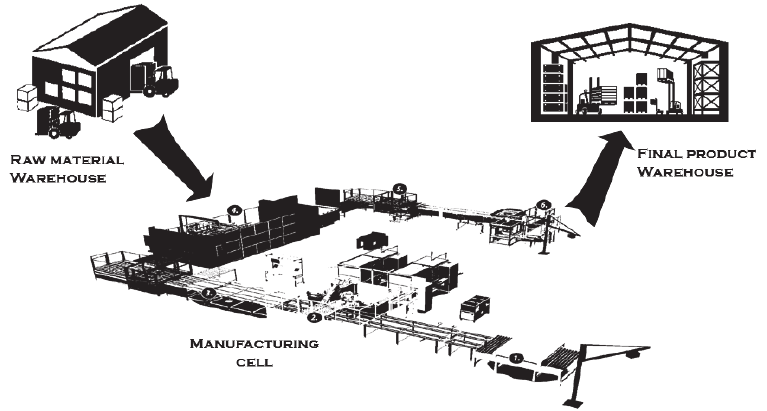
Fig. 1. Example configuration of a manufacturing cell with